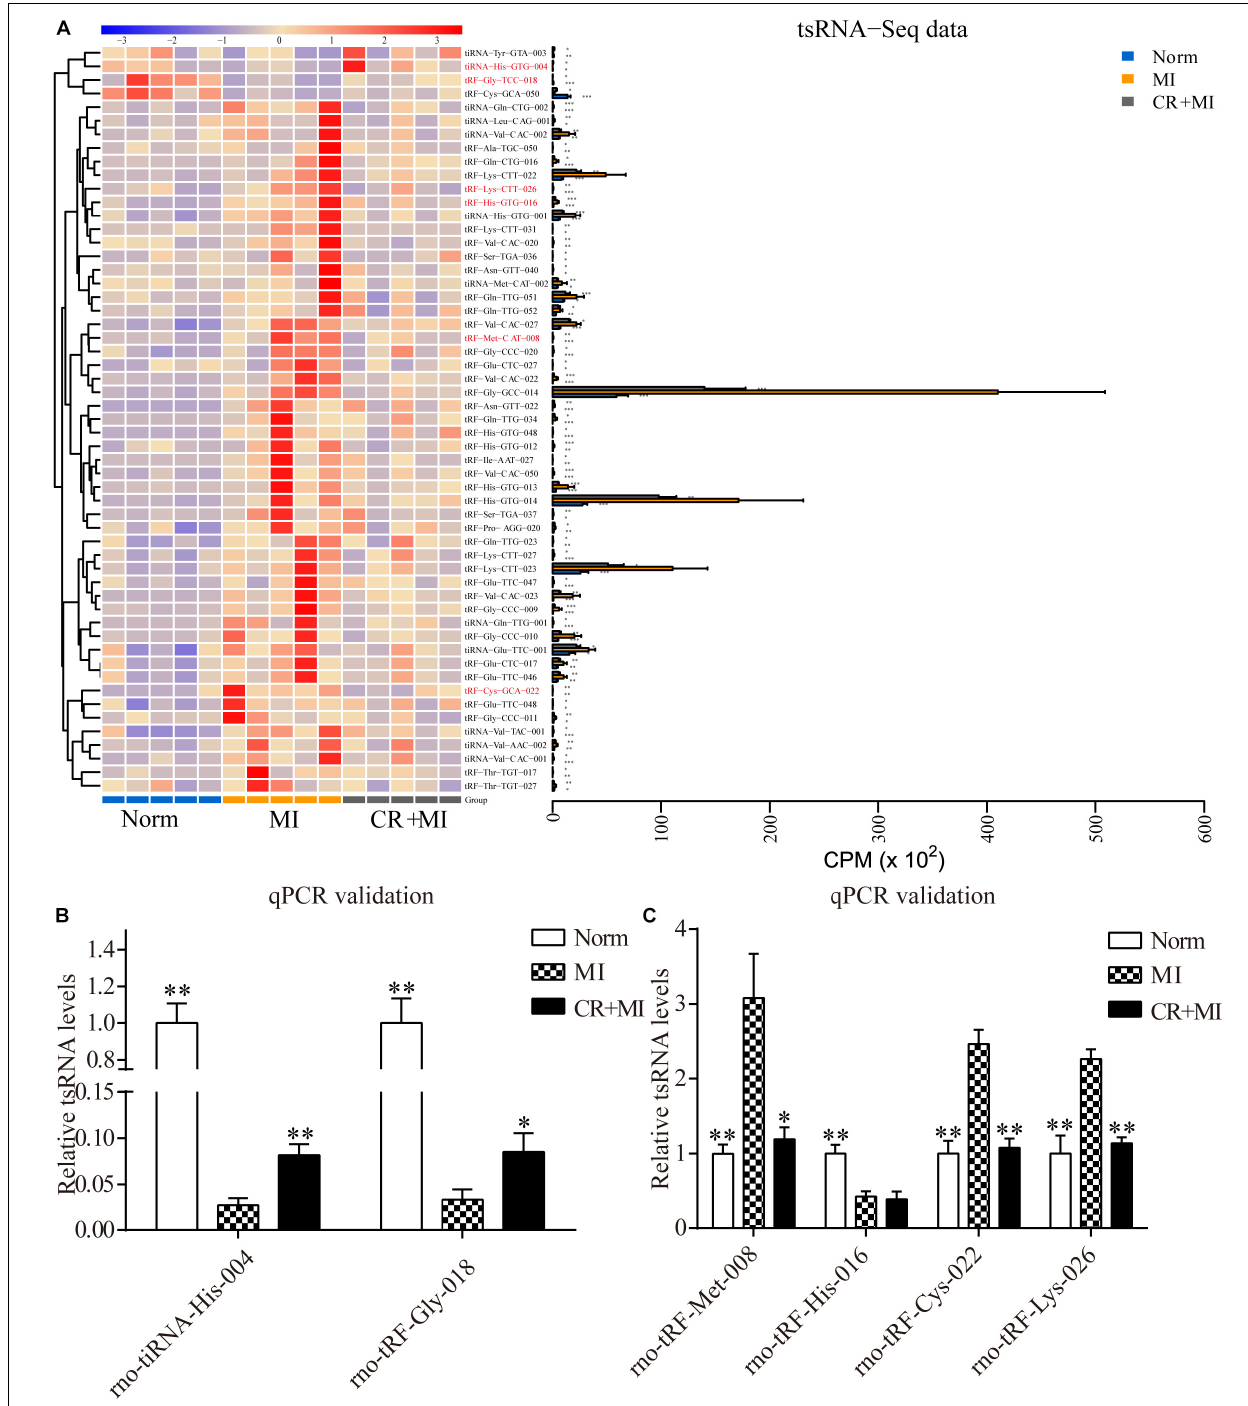
FIGURE 4 | Significantly altered CR-related tsRNAs and their verification via qRT-PCR. (A) Significantly altered CR-related tsRNAs are shown in the heat map. The colors in the panel indicate the relative expression levels (log 2 transformation). The color bar graph on the top panel shows the sample group at the top, and the color bar graph on the right side of the panel represents the partitioning performed using K-means. (B) qRT-PCR confirmation of the CR-related tsRNAs, tiRNA-His-GTG-004, and tRF-Gly-TCC-018, among the three groups. (C) qRT-PCR confirmation of CR-related tRF-Met-CAT-008, tRF-His-GTG-016, tRF-Cys-GCA-022, and tRF-Lys-CTT-026 among the three groups. The data are presented as the mean ± SEM ( n = 6). * P < 0.05, ** P < 0.01 compared with the MI group.